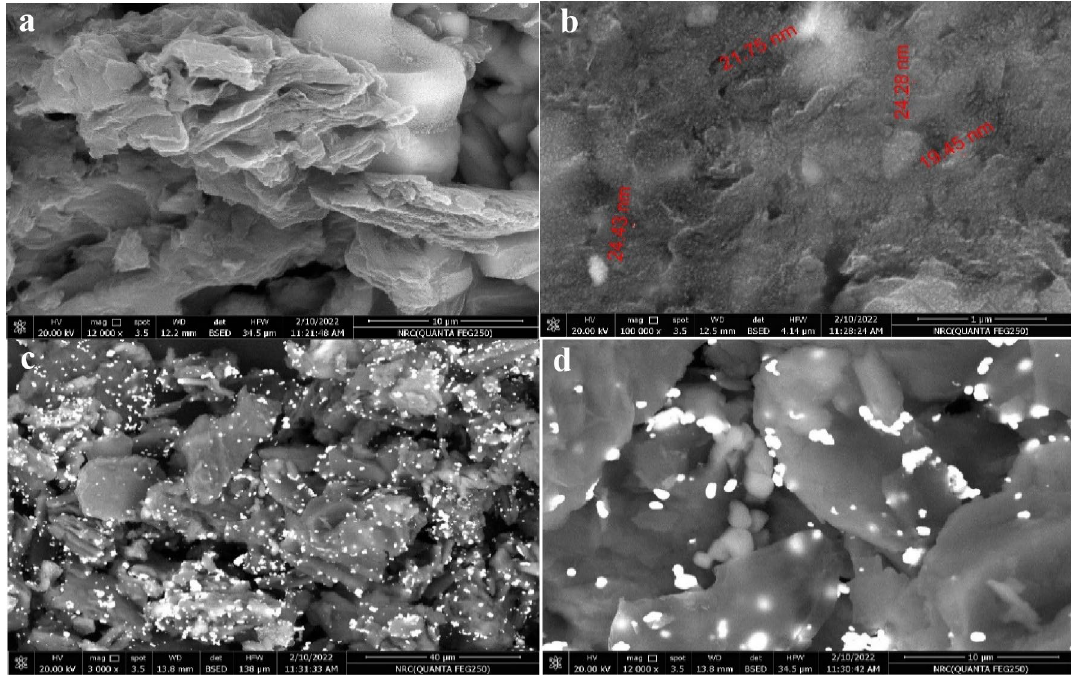
Fig. 4 SEM images of (a) rGO, (b) rGO@Ag 2%, (c) rGO@Ag 4% and (d) rGO@Ag 6%